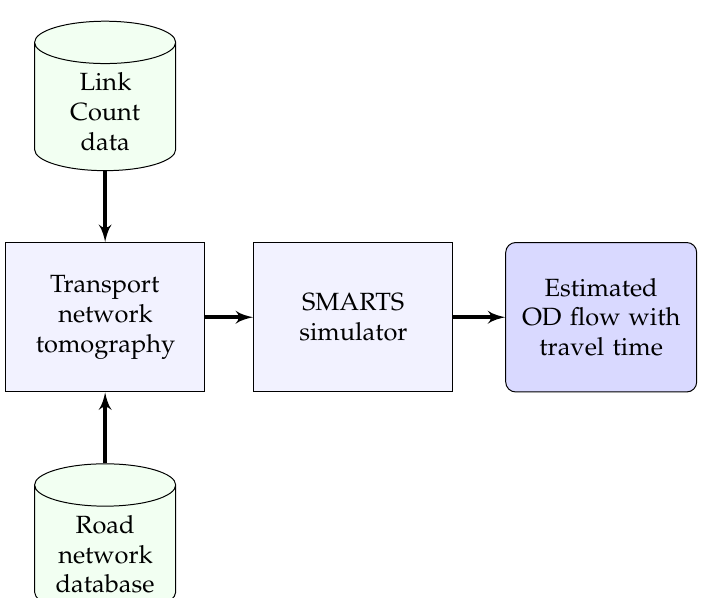
Figure 3. The block diagram of our transport network tomography model to estimate OD flows using link count data